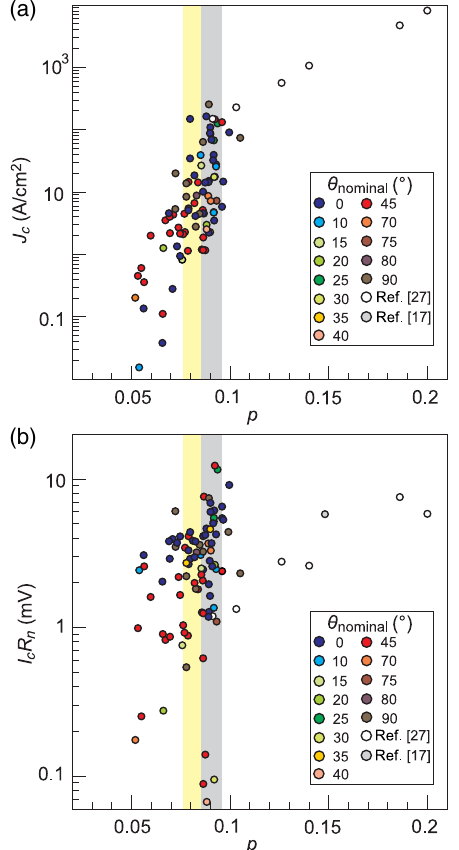
FIG. 9. (a) J c and (b) I c R n as a function of doping for junctions with different twist angles. The doping p is estimated from the corresponding T c 0 by using the empirical formula: T to tunneling in intrinsic Josephson junctions of a single BSCCO, as obtained from Ref. [27]. The gray circle is from previous 45° twist bicrystal experiments by using bulk crystals of BSCCO at optimal doping